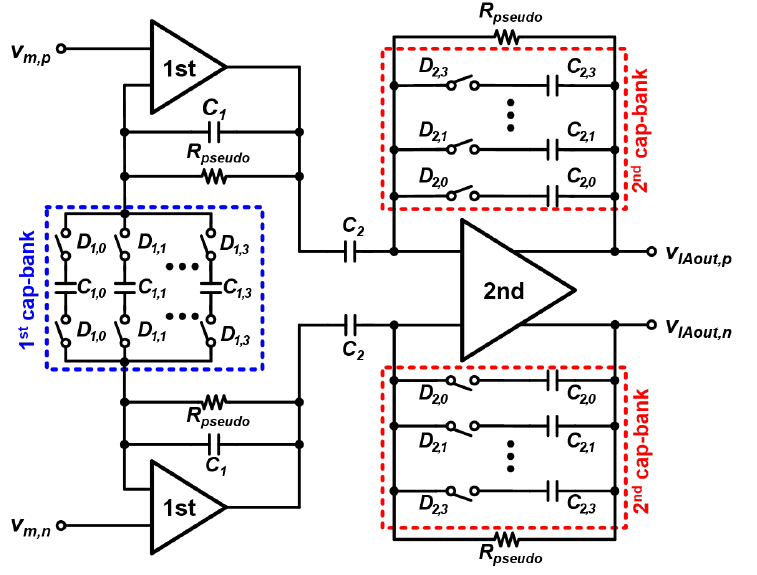
Figure 6. Circuit schematic of the